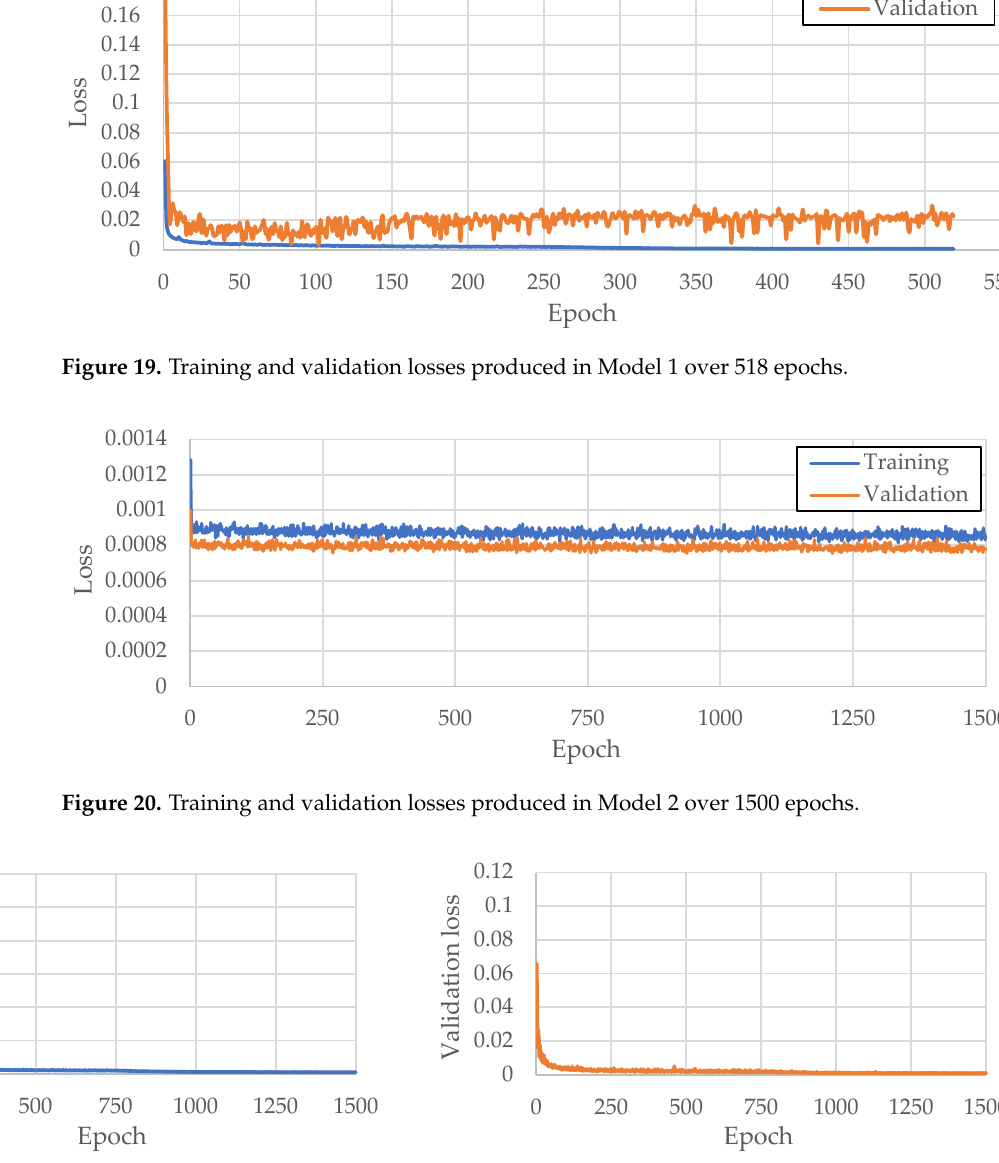
Figure 21. Training and validation losses produced in Model 3 over 1500 epochs.